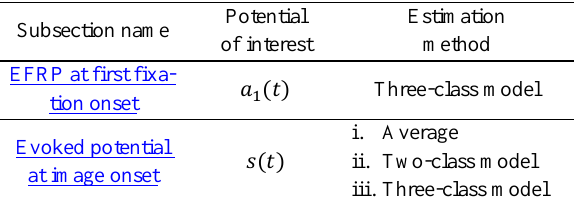
Table 5 Summary of model choices related to the potential of interest for the two following